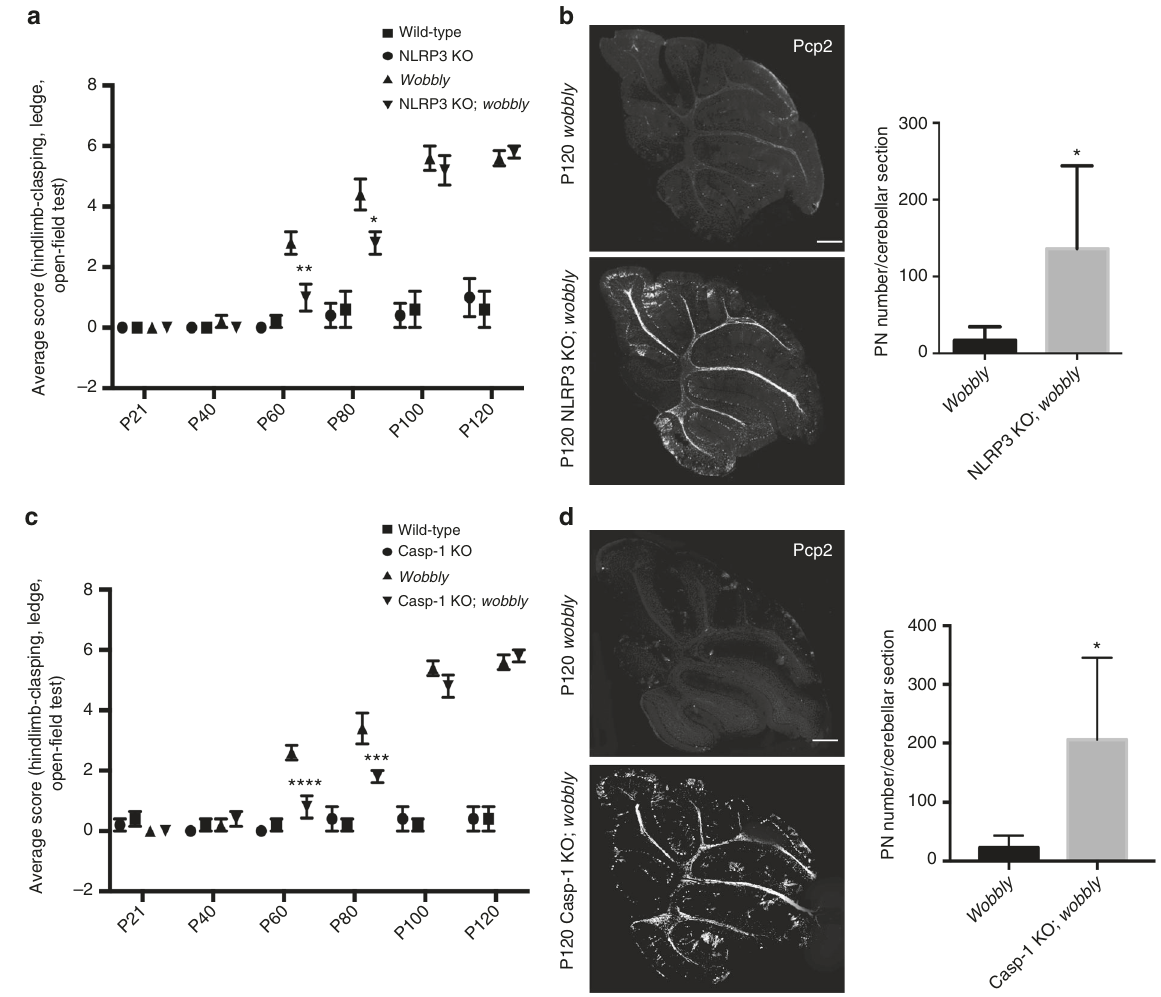
Fig. 8 Protective effect of NLRP3 and caspase-1 de fi ciency on the wobbly phenotype. a Ataxic phenotype analysis of NLRP3 KO, NLRP3 KO; wobbly and wobbly mice relative to wild-type controls. b Pcp2 Immuno fl uorescence and PN quanti fi cation of sagittal cerebellar sections of P120 mutant mice. c Behavioral analysis of caspase-1 (Casp-1) KO, Casp-1 KO; wobbly and wobbly animals relative to wild-type controls. d Immuno fl uorescence of P120 mutant mice sagittal cerebellar sections with Pcp2 antibody. PN quanti fi cation is presented. For ( a ) and ( c ) n = 6 (3 males and 3 females) for each of the genotypes. For ( b ) and ( d ) n = 5 for each of the genotypes; representative images are shown. Scale bars, 500 μ m. Statistical evaluation: ( a , c ) two-way ANOVA and Sidak ’ s multiple comparisons test; ( b , d ) two-tailed t test. Statistically signi fi cant differences are indicated ( * P ≤ 0.05; ** P ≤ 0.01; *** P ≤ 0.001; **** P ≤ 0.0001). Data represent mean ±